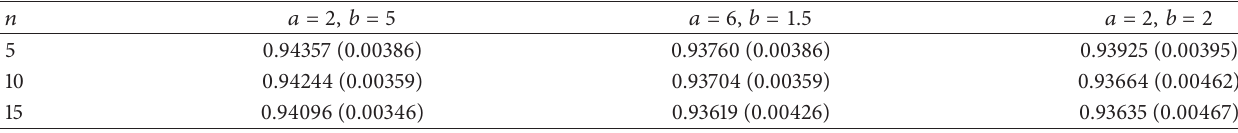
Table 3: Average empirical credible level (1 − 𝛼) for 𝐶 𝐿 under SE loss function when 𝛼 = 0.05 .